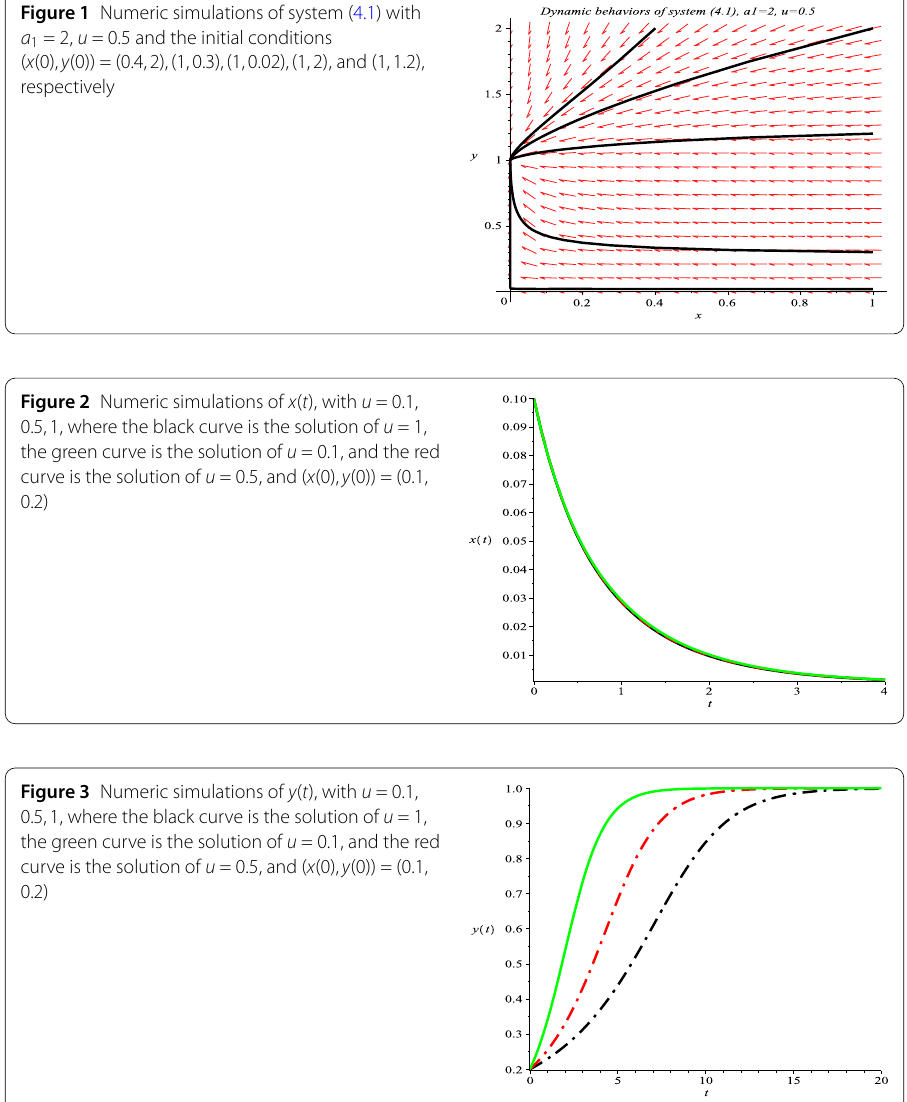
Figure 1 Numeric simulations of system (4.1) with a 1 = 2, u = 0.5 and the initial conditions ( x (0), y (0)) = (0.4,2),(1,0.3),(1,0.02),(1,2), and (1,1.2), respectively